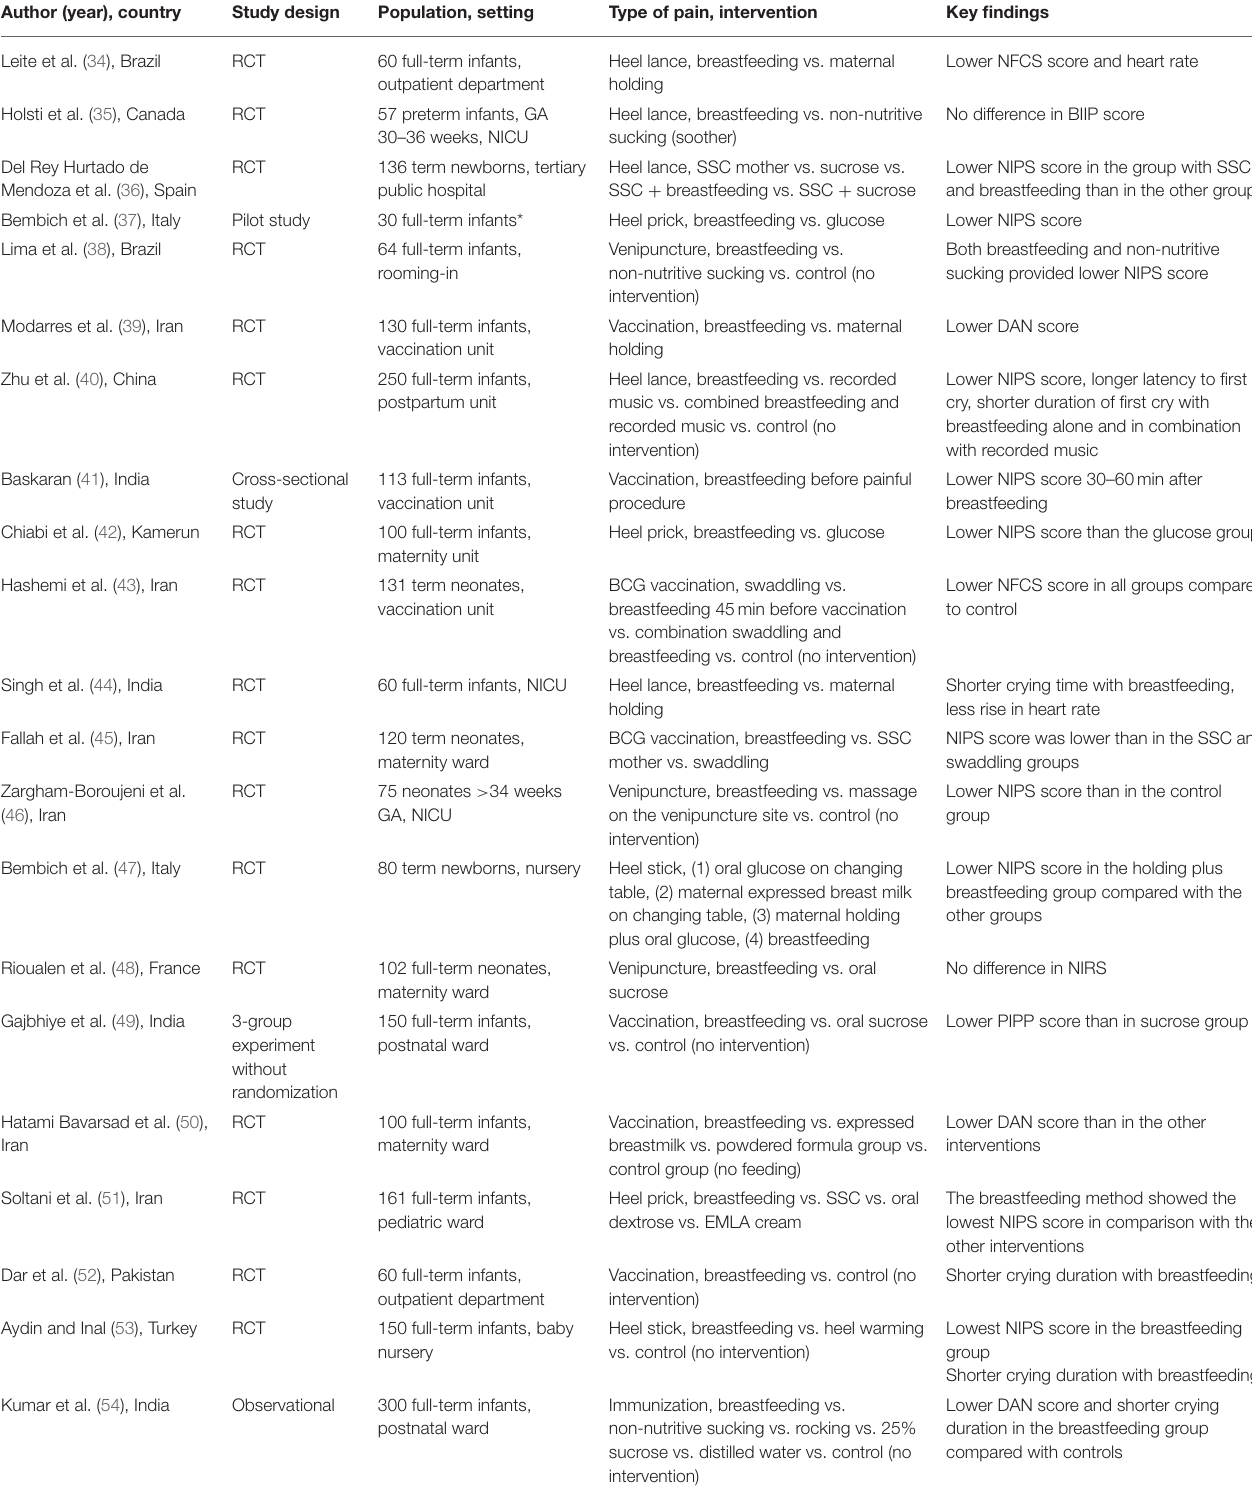
TABLE 1 | Evidence for parent-delivered interventions: